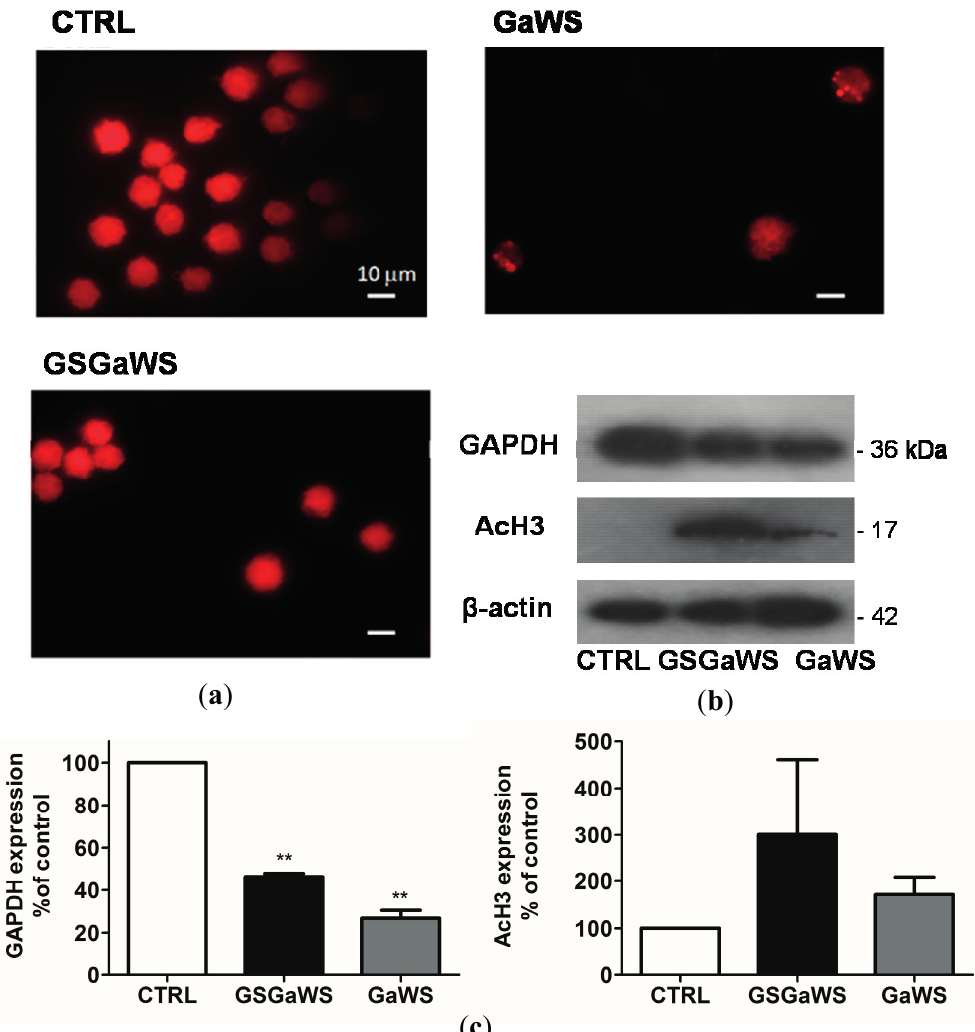
Figure 7. Fluorescence microscope images of the nucleus ( a ) stained with PI solution of the HuT 78 tumor cells after 24 h of incubation, untreated (CTRL) and treated with 0.32 mg (d.w.)/mL and 0.44 mg (d.w.)/mL of GaWS and GSGaWS extracts, respectively; ( b ) western blot analysis of the protein expression of the HuT 78 treated with 0.69 mg (d.w.)/mL and 6.67 mg (d.w.)/mL of GaWS and GSGaWS extracts, respectively. ( c ) Significant changes of the AcH3 and GAPDH expression were observed after both treatments. β -actin was used as the loading control. Western blot analysis was performed on a 15% SDS-PAGE with ~50 μ g of total protein extracts. Results are indicative of three individual experiments. ** p -value = 0.0053